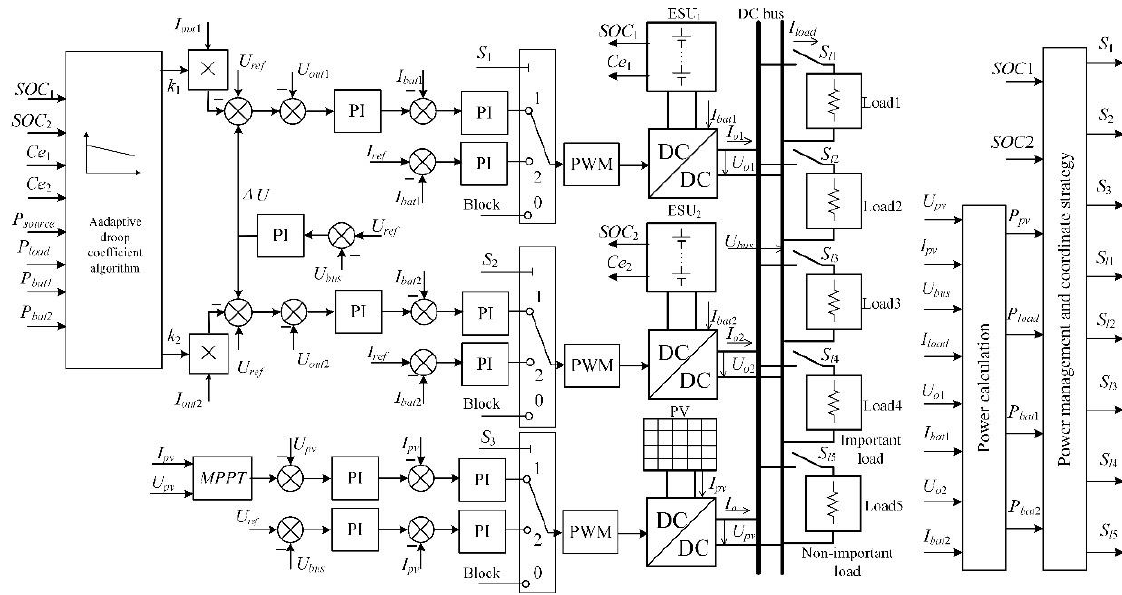
Figure 9. Coordinated control diagram of DC microgrid.